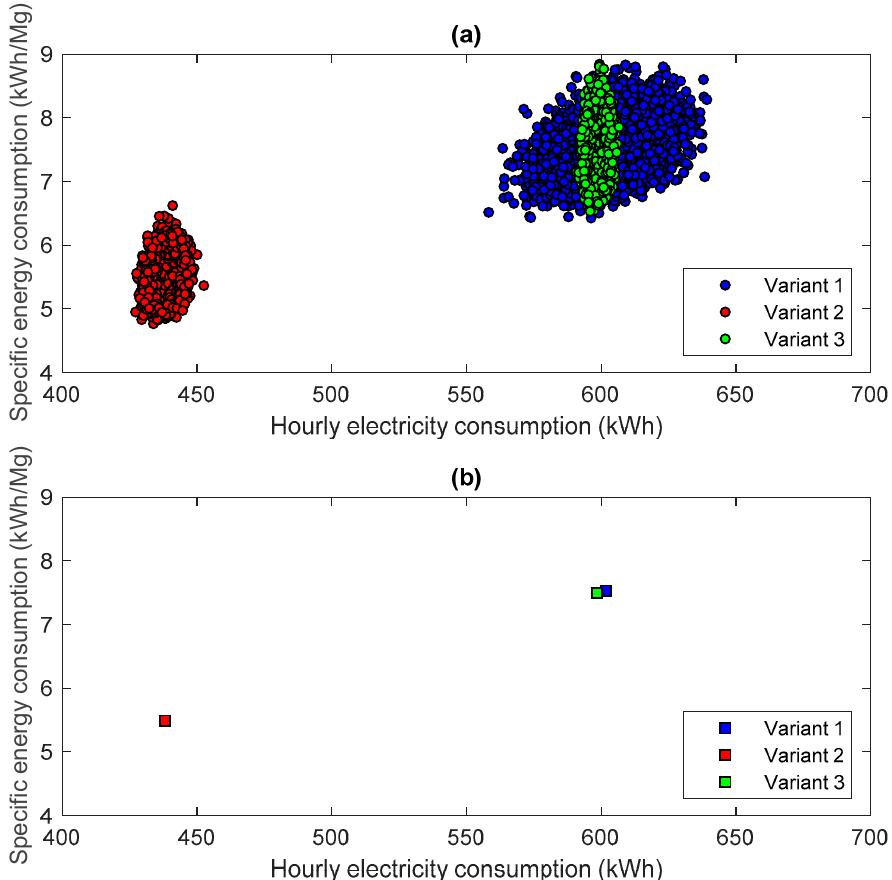
Figure 13. Monte Carlo simulation results—relationship between the specific energy consumption of the mill and the hourly electric energy consumption by a particular drive: ( a ) work areas of the selected drive systems, ( b ) averaged work points for Variant 1 (601.71 kWh; 7.53 kWh/Mg), Variant 2 (438.14 kWh; 5.49 kWh/Mg), and Variant 3 (598 46 kWh; 7.50 kWh/Mg).